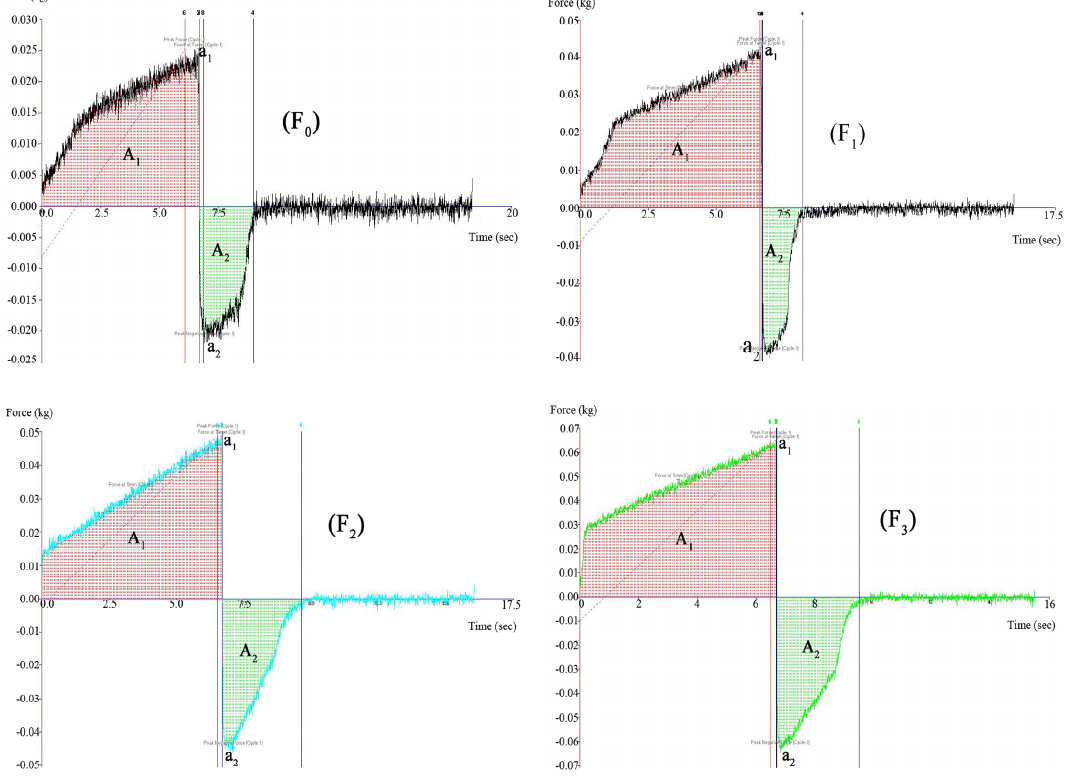
Figure 1. The effect of NB/HP- β -CD concentration on hardness, cohesiveness, strength and adhesiveness of thermosensitive composite hydrogel (F